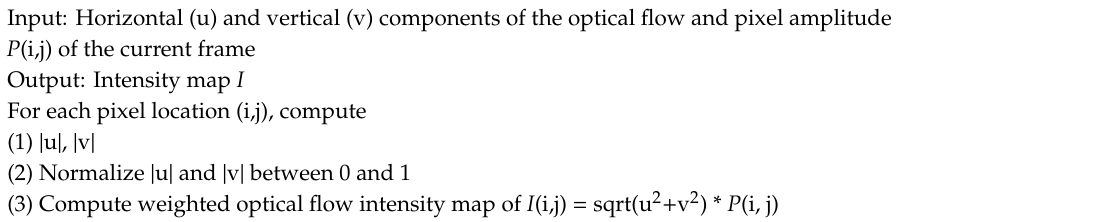
Algorithm 1: Weighted optical flow intensity mapping of optical flow image